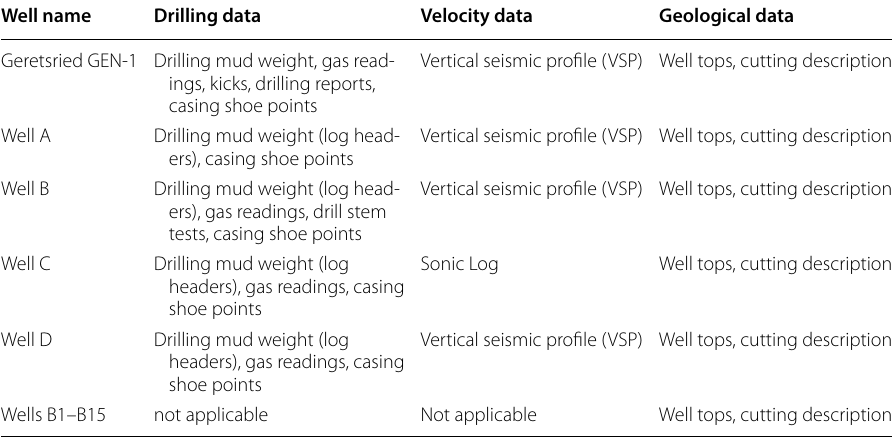
Table 1 Well data used in this